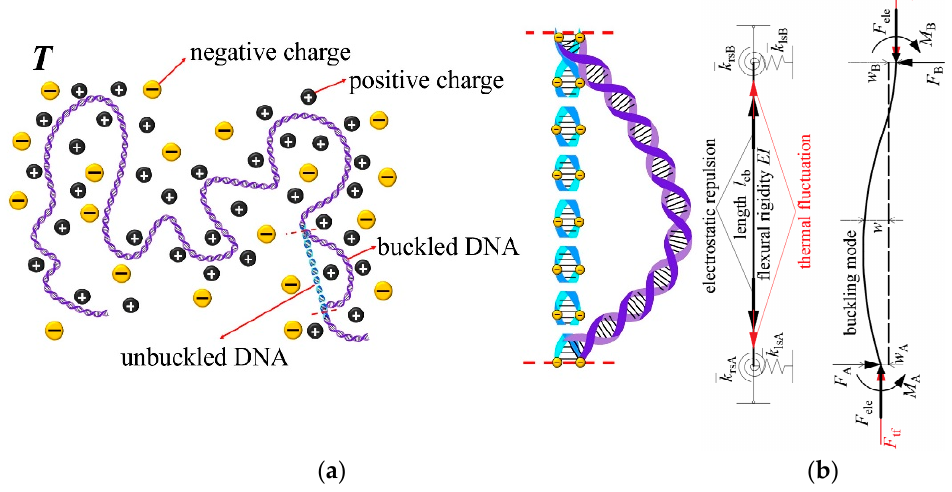
Figure 1. ( a ) A bent fragment isolated from a long DNA chain and ( b ) buckling of DNA fragment under the combined effects of interior electrostatic repulsion, thermal fluctuation, and effective mechanical end-constraints.